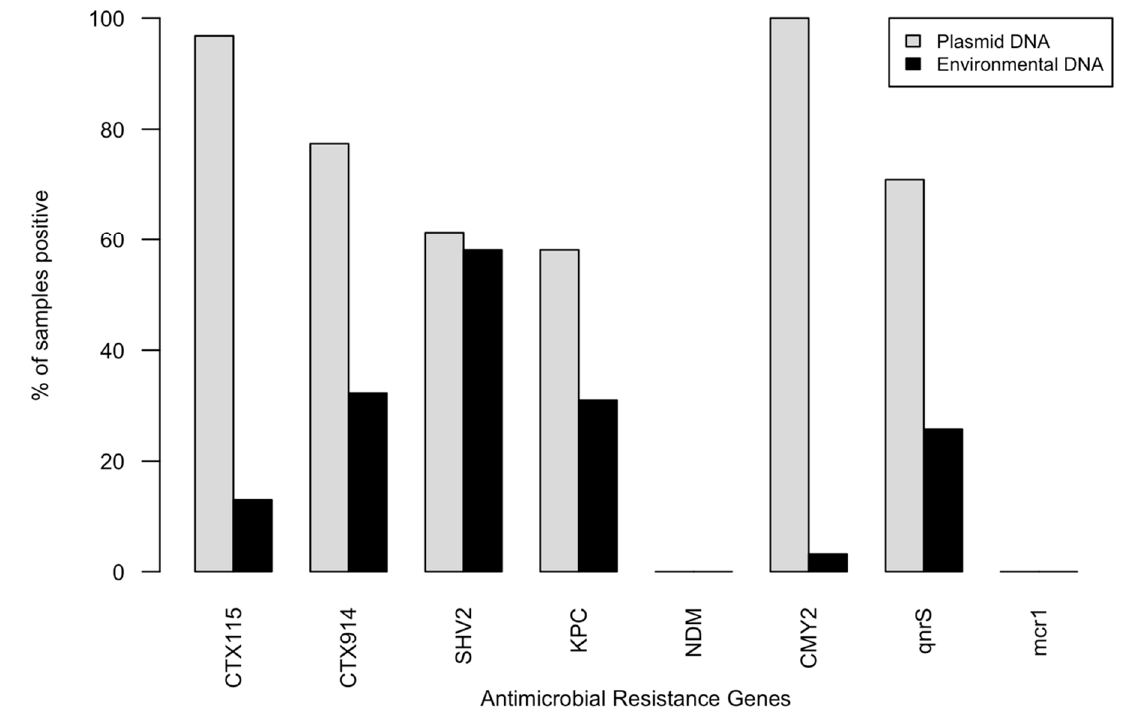
Figure 2. Percent of isolate plasmid DNA samples ( n = 31) and environmental DNA samples, ( n = 29), that had positive amplifications for genetic determinants of antimicrobial resistance.